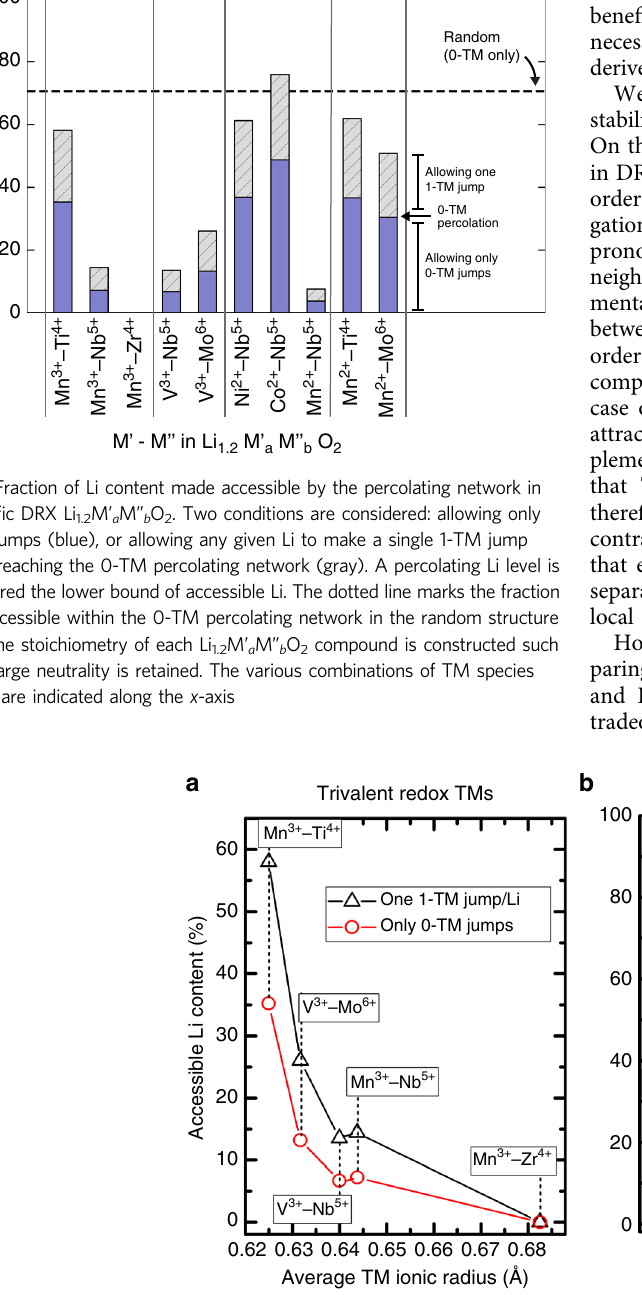
Fig. 6 Correlation between accessible Li contents and ionic radii in various DRXs. a Accessible Li content as a function of the average TM ionic radius in DRXs composed of trivalent redox-active TMs, by allowing only 0-TM jumps (red) or allowing any given Li to make a single 1-TM jump before reaching the 0-TM percolating network (black). b Accessible Li content as a function of the divalent TM ionic radius in DRXs with divalent redox-active TMs and various stabilizers, by allowing only 0-TM jumps. The ionic radius of Li + is marked at 0.76 Å. All the compositions listed have the same Li-excess level of